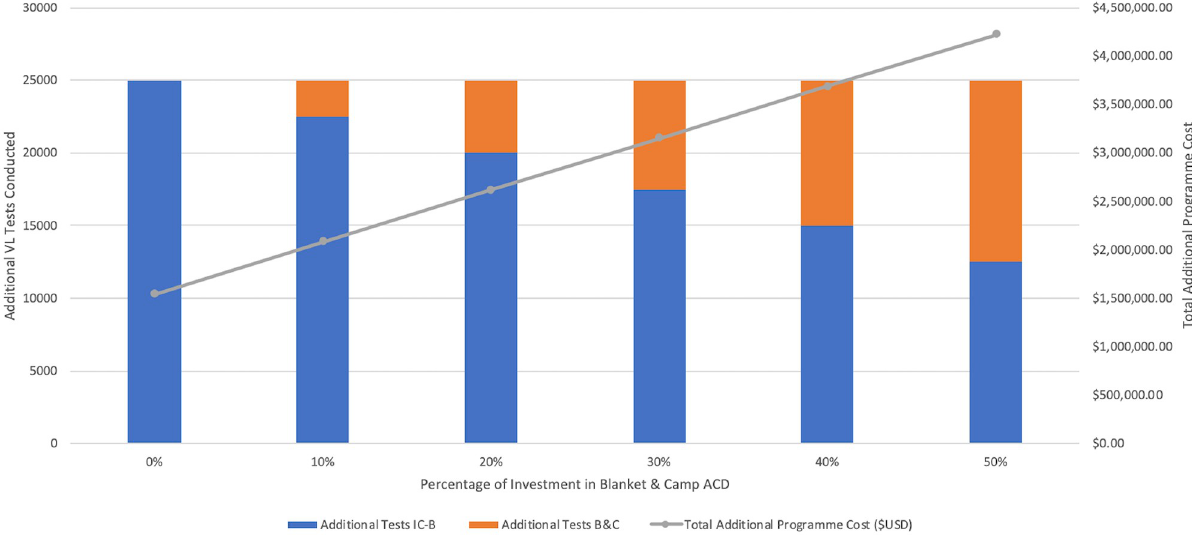
Fig 10. Cost of scaling up ACD to conduct additional tests. Cost of scaling up index case-based (IC-B) and blanket & camp (B&C) ACD to conduct 25,000 additional VL tests. Total programme cost includes both IC-B and B&C together, as if managed by a single funder.